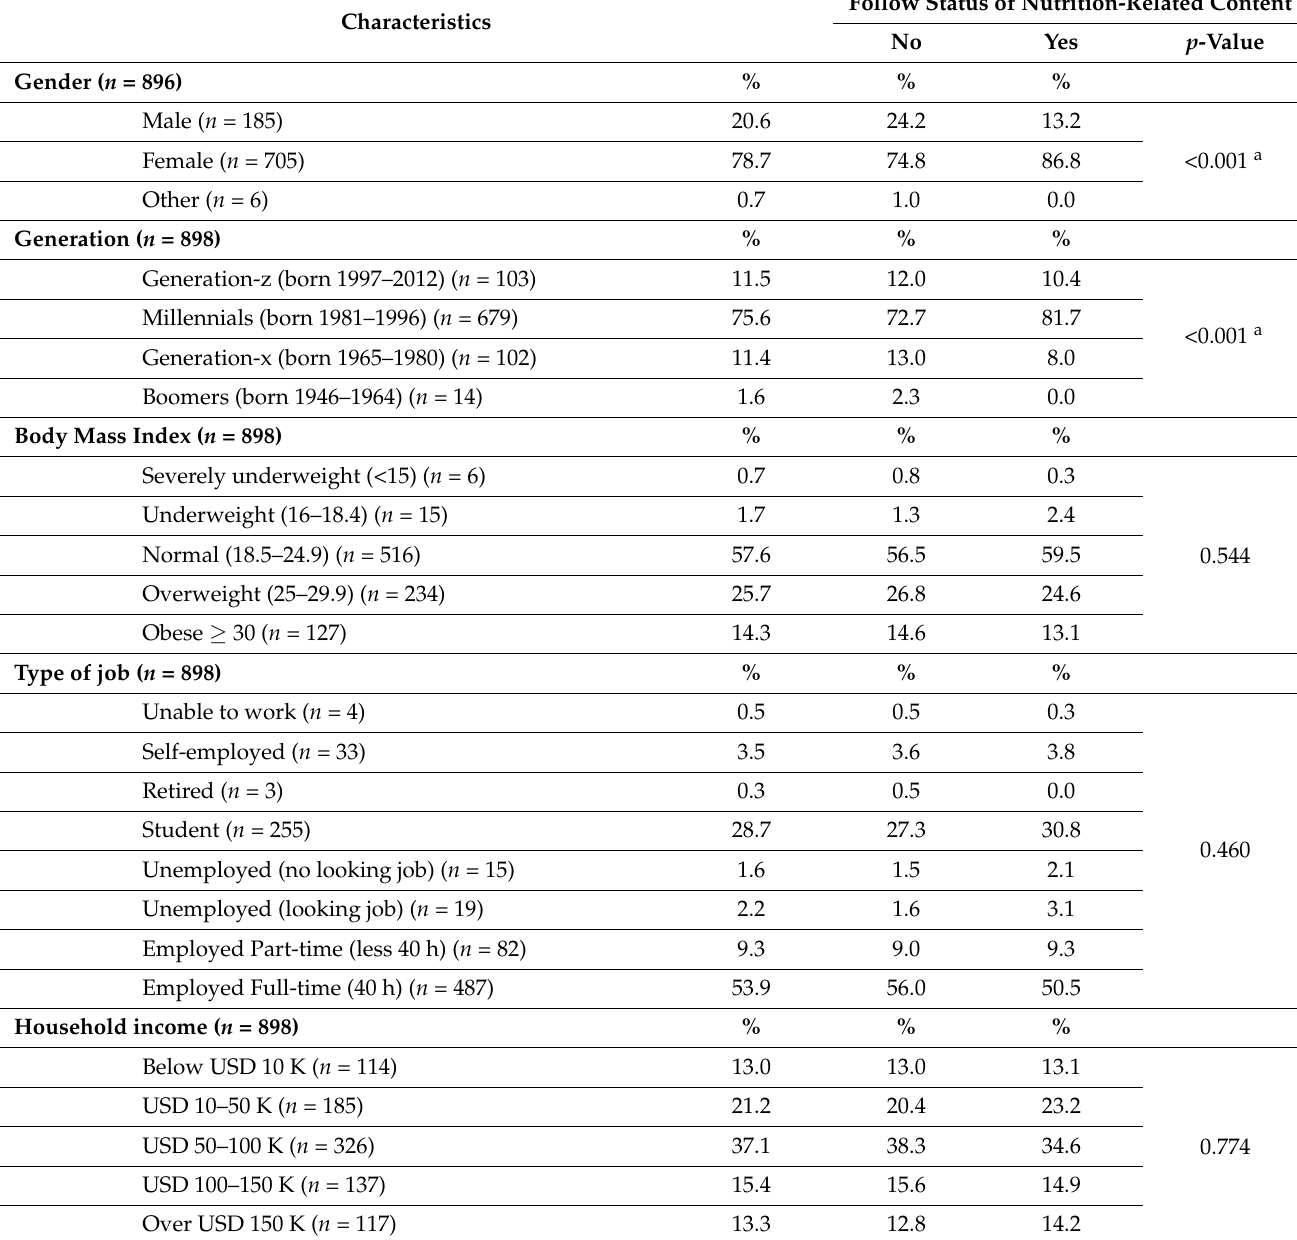
Table 1. Characteristics of the sample and relations with the follow status of nutrition-related content on